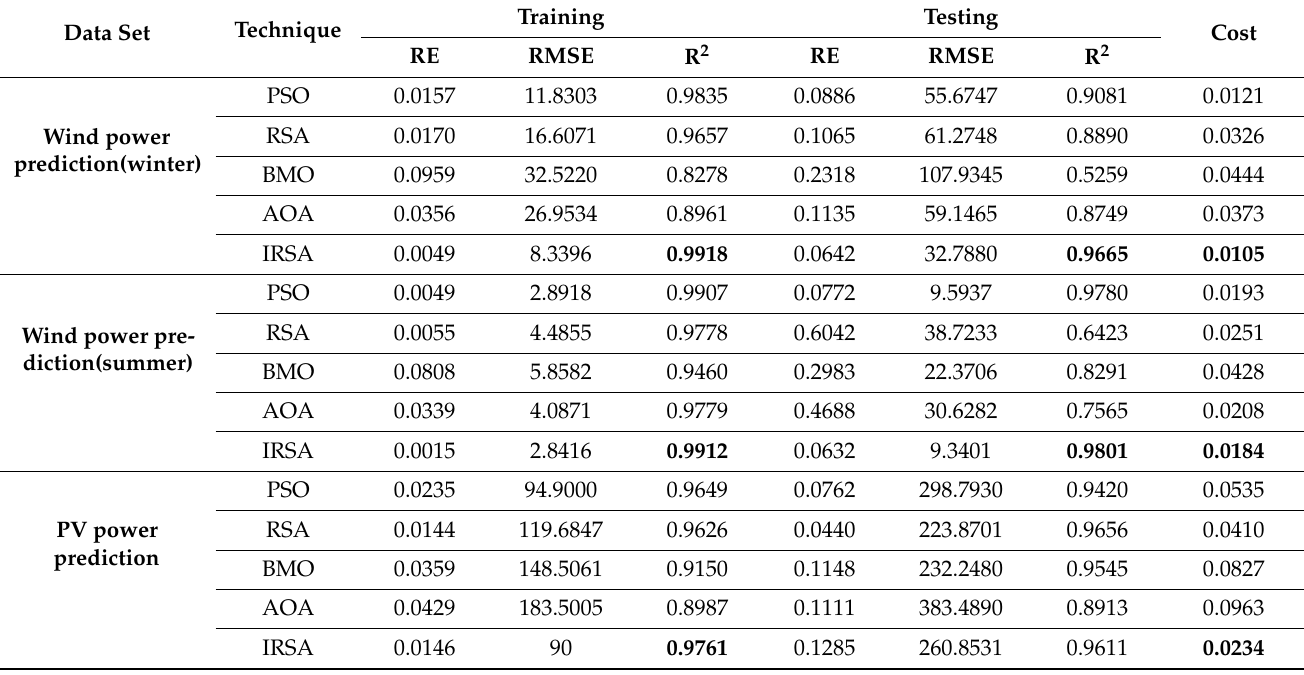
Table 11. Statistical evaluation for wind and solar